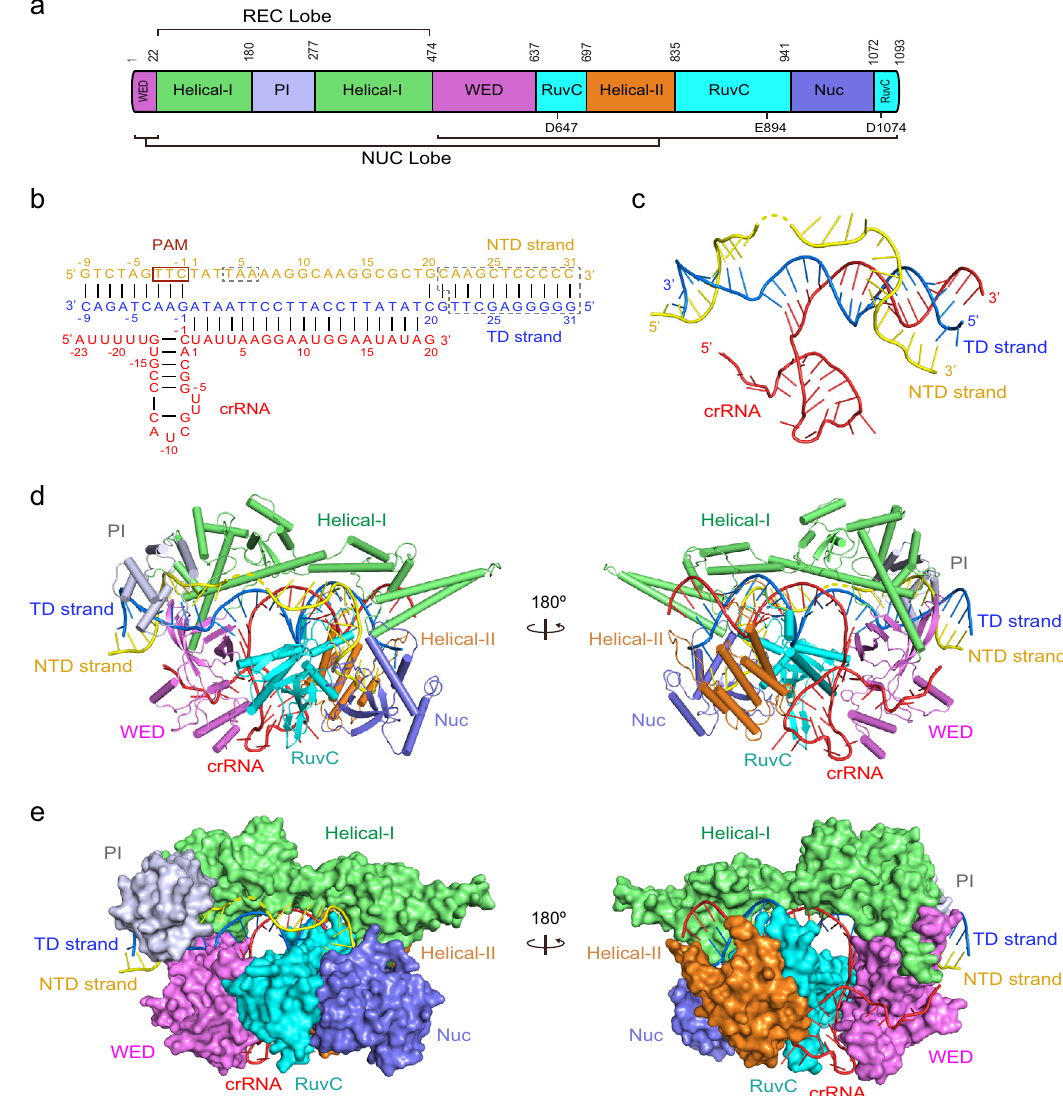
Fig. 1 Crystal structure of the Cas12i1 pre-cleavage R-loop complex. a Domain organization of Cas12i1. Catalytic residues within the RuvC domain are annotated below the diagram. b Schematic representation of the R-loop structure formed by crRNA and the target duplex. Disordered regions are surrounded by gray dashed lines. c View of the R-loop structure in the complex. d Overall structure of the Cas12i1 pre-cleavage R-loop complex shown in two different orientations and color-coded as de fi ned in ( a ) and ( b ). e Surface representations of the Cas12i1 pre-cleavage R-loop complex shown in the same views as in ( d